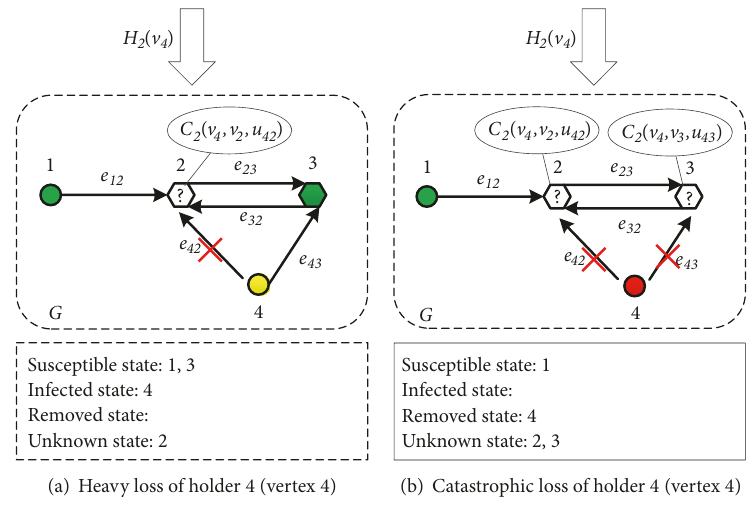
Figure 4: Decision behavior of holder 4 when it suffers a heavy or catastrophic